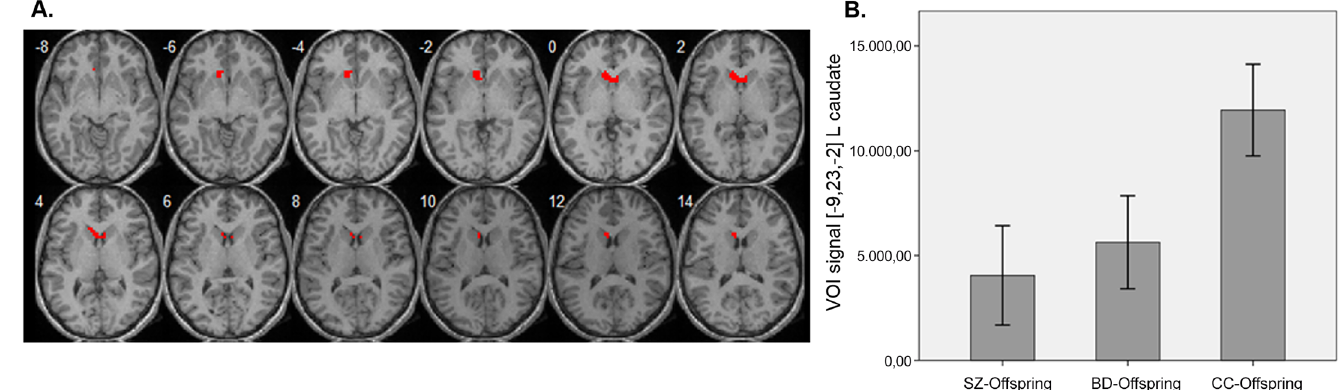
Fig 1. A. Cluster showing group differences within the Basal Ganglia Network overlaid on a normalised 3D image. B. Mean signal intensity for each group within the global maxima in the BGN. Error bars represent the 95% confidence